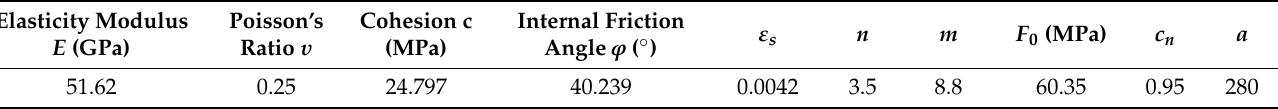
Figure 2. Schematics of boundary conditions for uniaxial compression: ( a ) an ideal case with a free end; ( b ) an extreme case with a fixed end. end; ( b ) an extreme case with a fixed end. Table 2. The material parameters of rock adopted in numerical simulation.